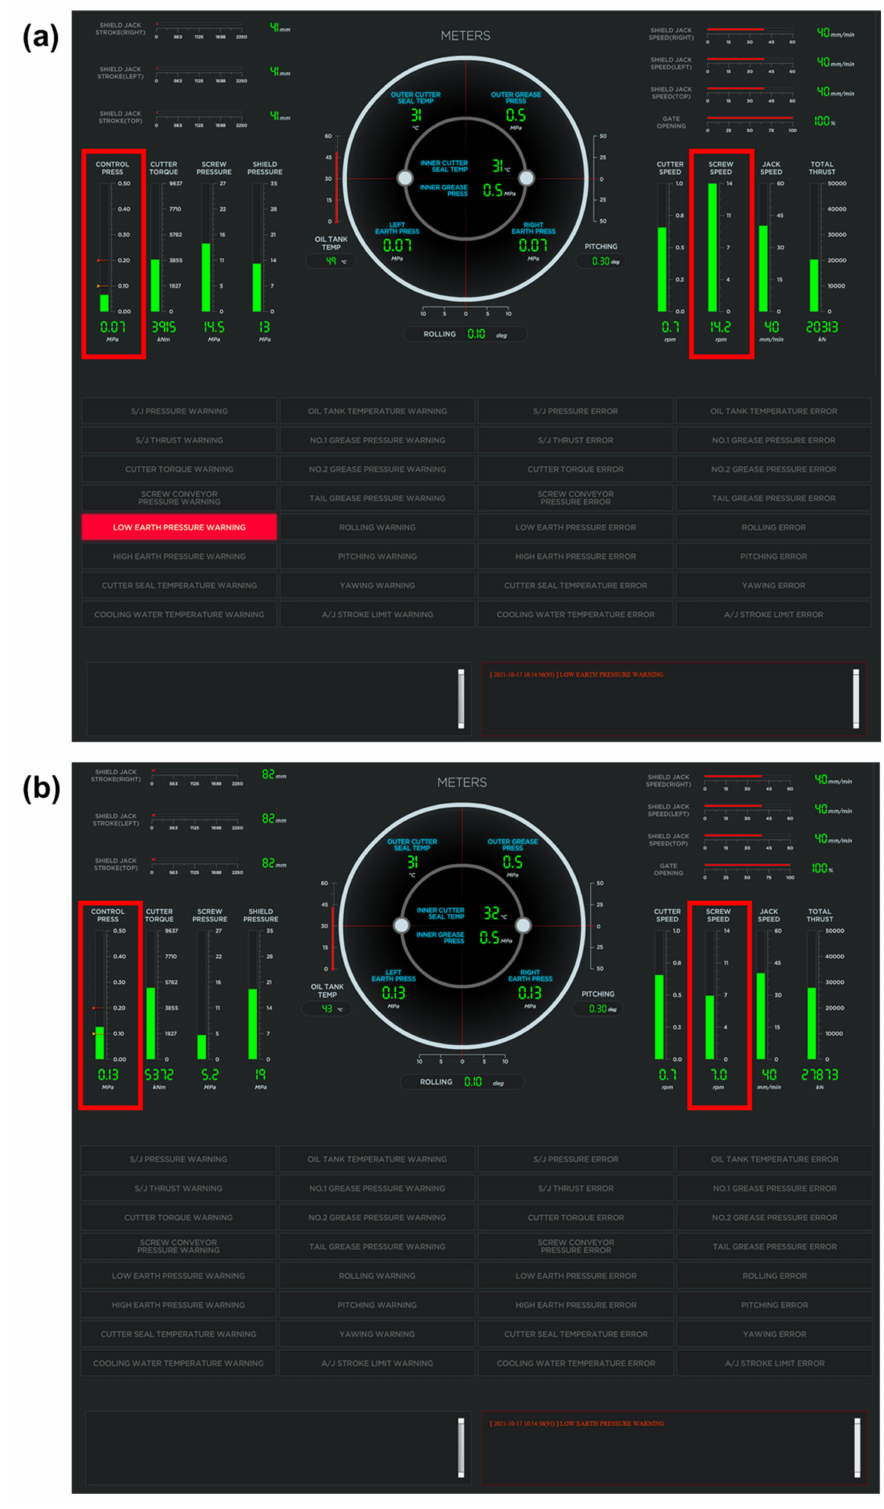
Figure 13. Simulation test results induced by: ( a ) control pressure decrease; and ( b ) screw conveyor rotation speed